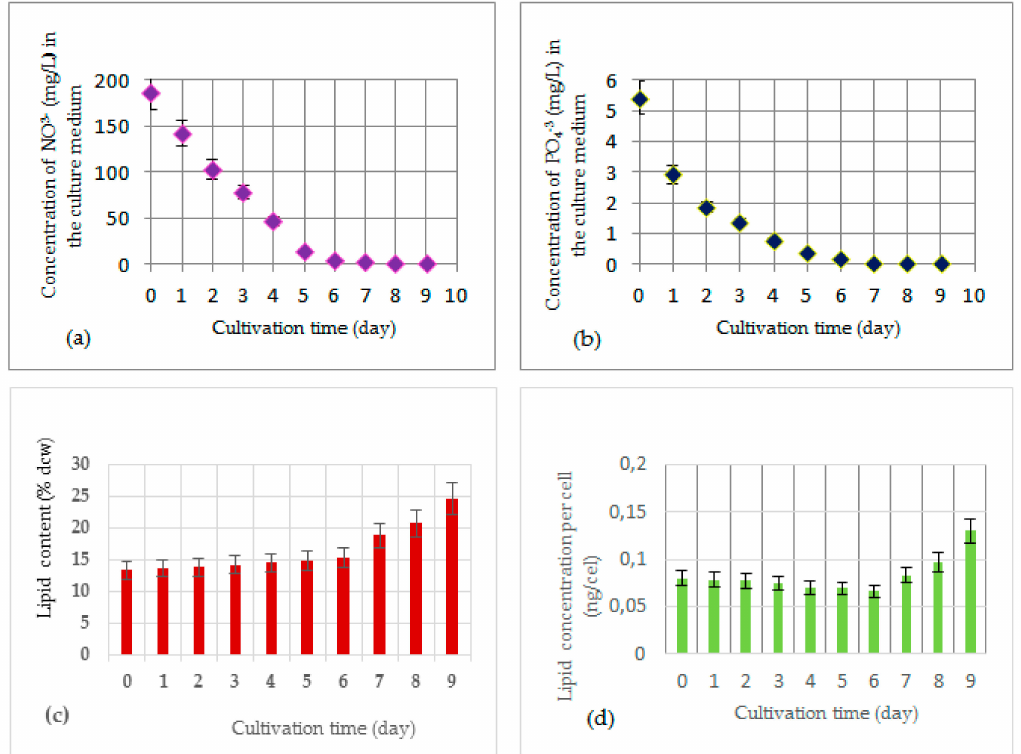
Figure 2. Production of total lipids in R. subcapitata immobilized in alginate beads, over a period of 10 days (culture performed in batch and in duplicate). ( a ) Nitrate consumption; ( b ) phosphate consumption; ( c ) variations in lipid content per dry weight of cells; ( d ) variations in lipid concentration per cell. t 0 = d 1